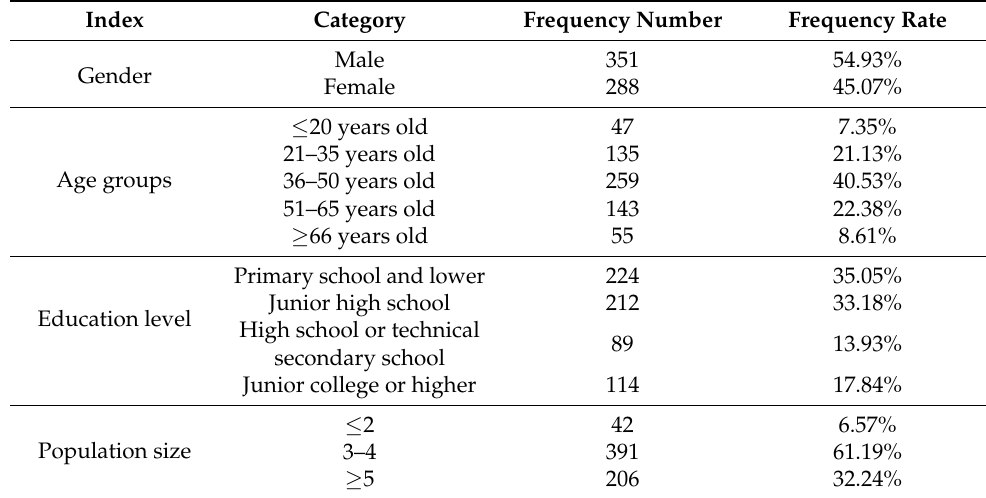
Table 1. Basic characteristics of sample